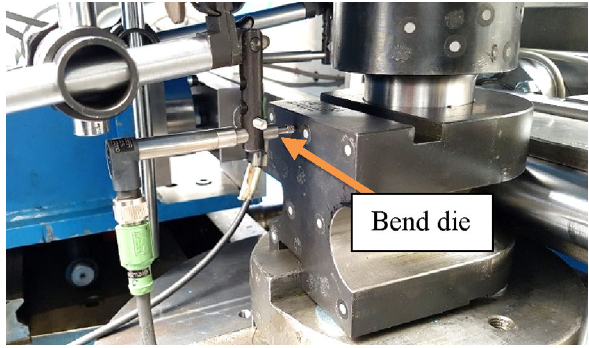
Fig. 14 Axis shifting of the pressure die, front